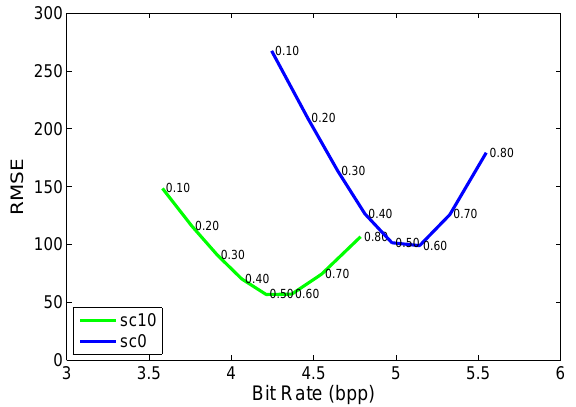
Figure 14. RMSE versus BR by varying K min for the Yellowstone scene 10 in the BSQ